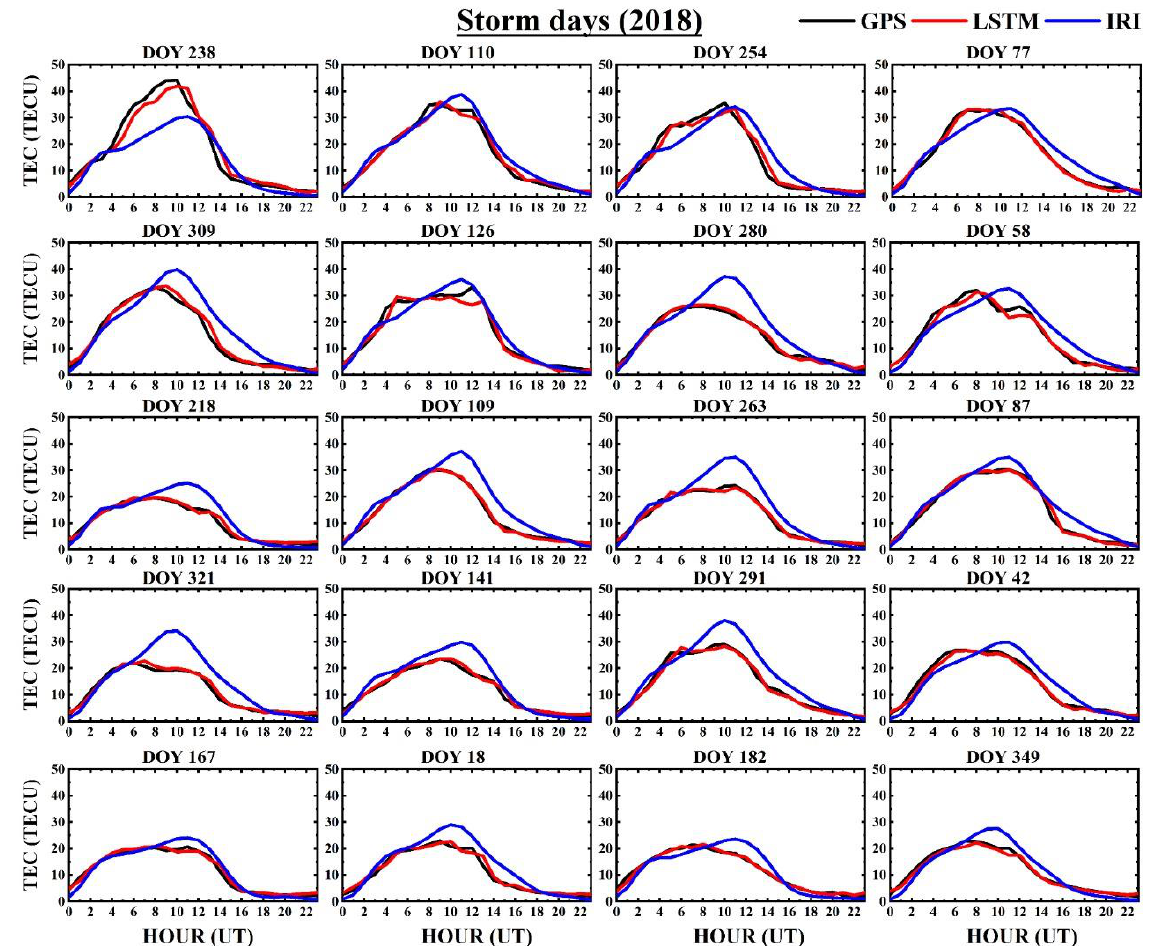
Figure 5. Comparison of the TECs predicted for selected geomagnetically disturbed days of the year (DOY) in 2018 by the GPS TEC (black solid line), IRI (blue solid line), and LSTM (red solid line) at a low latitude station Bangalore (IISC) in India.